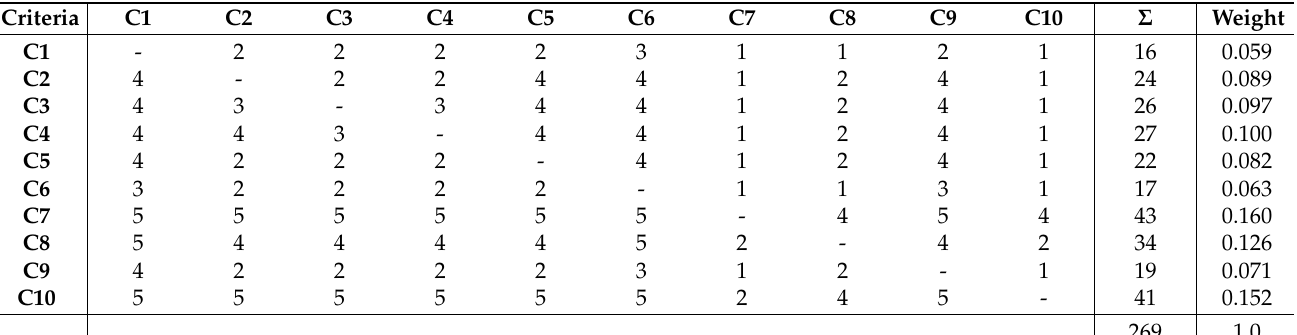
Table 4. Pairwise comparison for the weighting of the criteria examined. The pairwise comparison is carried out by the authors. The weighting results from the ratio of the sum of the single criterion to the total sum of the criteria.